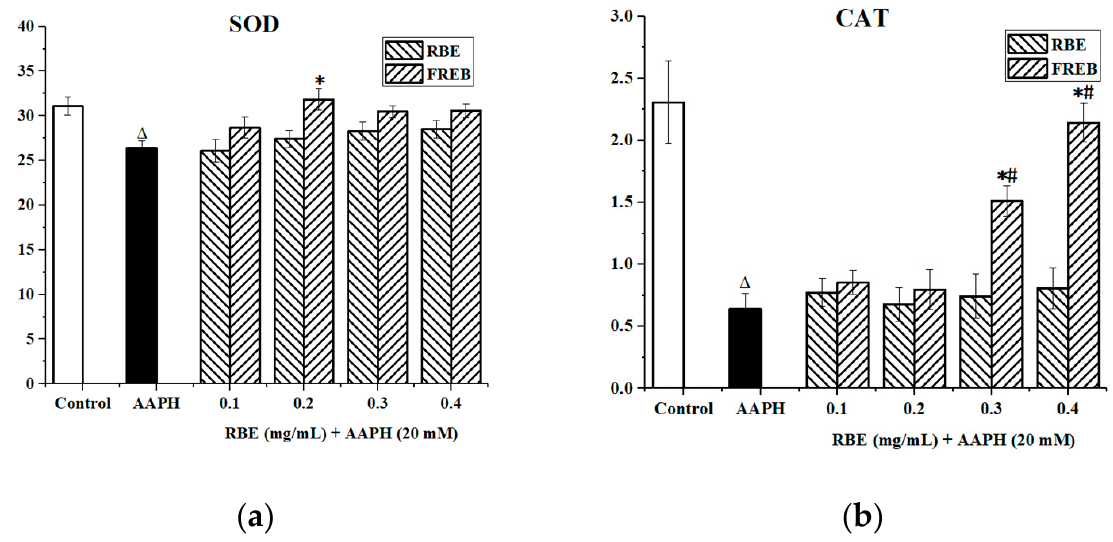
Figure 5. Effects of RBE and FRBE on enzyme activity levels in zebrafish exposed to AAPH. ( a ) Activity of SOD (U mg protein-1); ( b ) activity of CAT (U mg protein-1). Experiments were per- formed in triplicate, and the data are expressed as the means ± SE; Δ p < 0.05 compared to the control group; * p < 0.05 compared to the AAPH-treated group; # p < 0.05 for the comparison between RBE and FRBE.